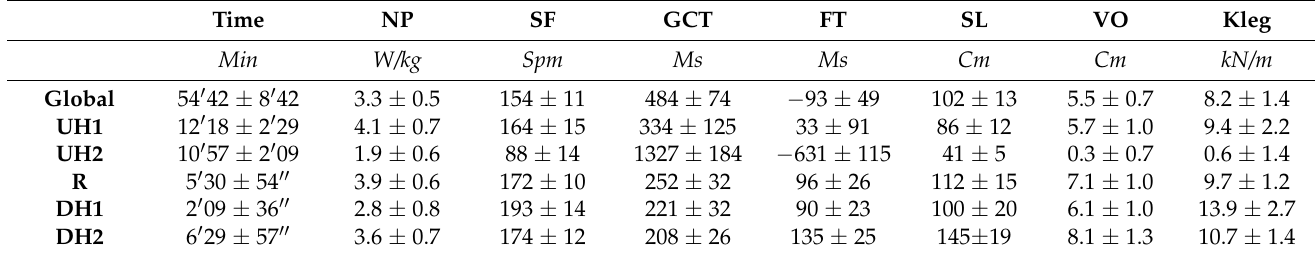
Table 2. Avg ± SD values of time, normalized power, stride frequency, ground contact time, flight time, step length, vertical oscillation, and leg stiffness over the entire course and over each defined area of the